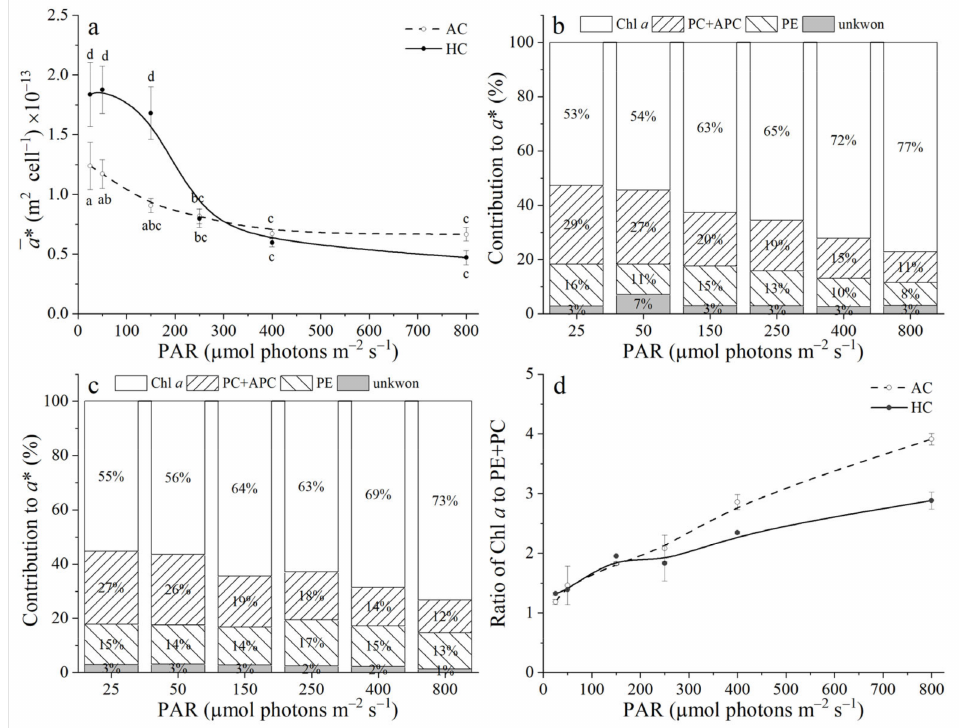
Figure 5. The average optical absorption cross section ( ¯a *) per cell ( a ), relative contributions (( b ) for AC, ( c ) for HC) to ¯a * by different pigments, and the ratio of Chl a to phycobilins ( d ) in Synechococcus cells grown under different light levels combined with the ambient (AC, 415 µ atm, the dotted line) or elevated (HC, 1000 µ atm, the solid line) p CO 2 . The values are means ± SD of triplicate cultures. Different letters indicate significant ( p < 0.05) differences among the